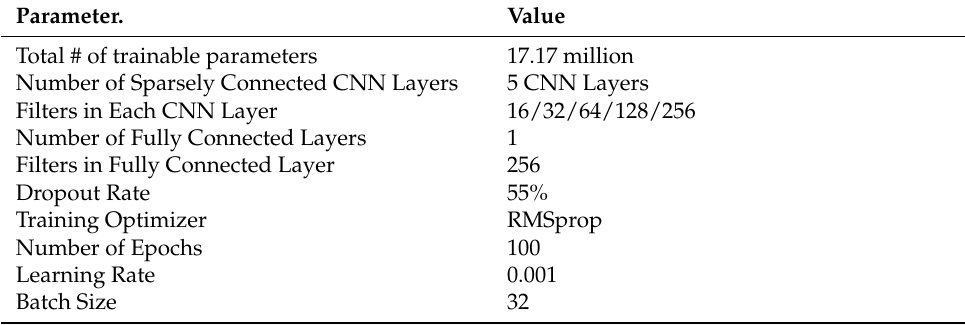
Table 1. Summary of ShrapML Architecture and Training Parameters.